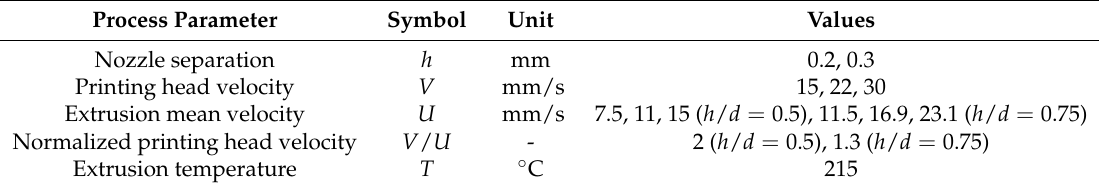
Table 1. Experimental tests